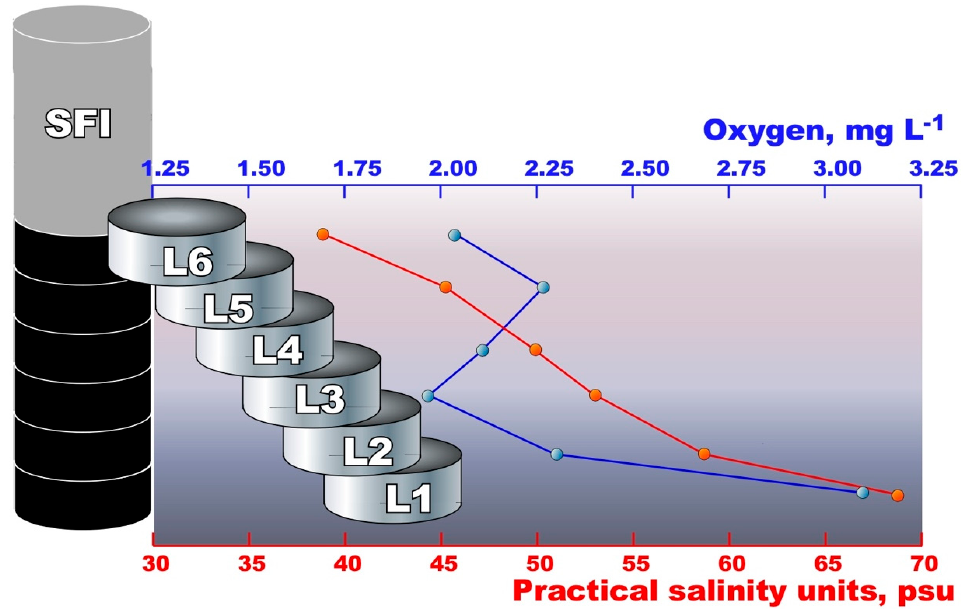
Figure 1. Salinity and oxygen concentration profiles observed in the lower six sections of the simu- lated fast ice core (SFI) after a month in the dark at − 2 °C. The data are mean values from three simulated fast ice core (SFI) after a month in the dark at − 2 ◦ C. The data are mean values from three parallel measurements. parallel